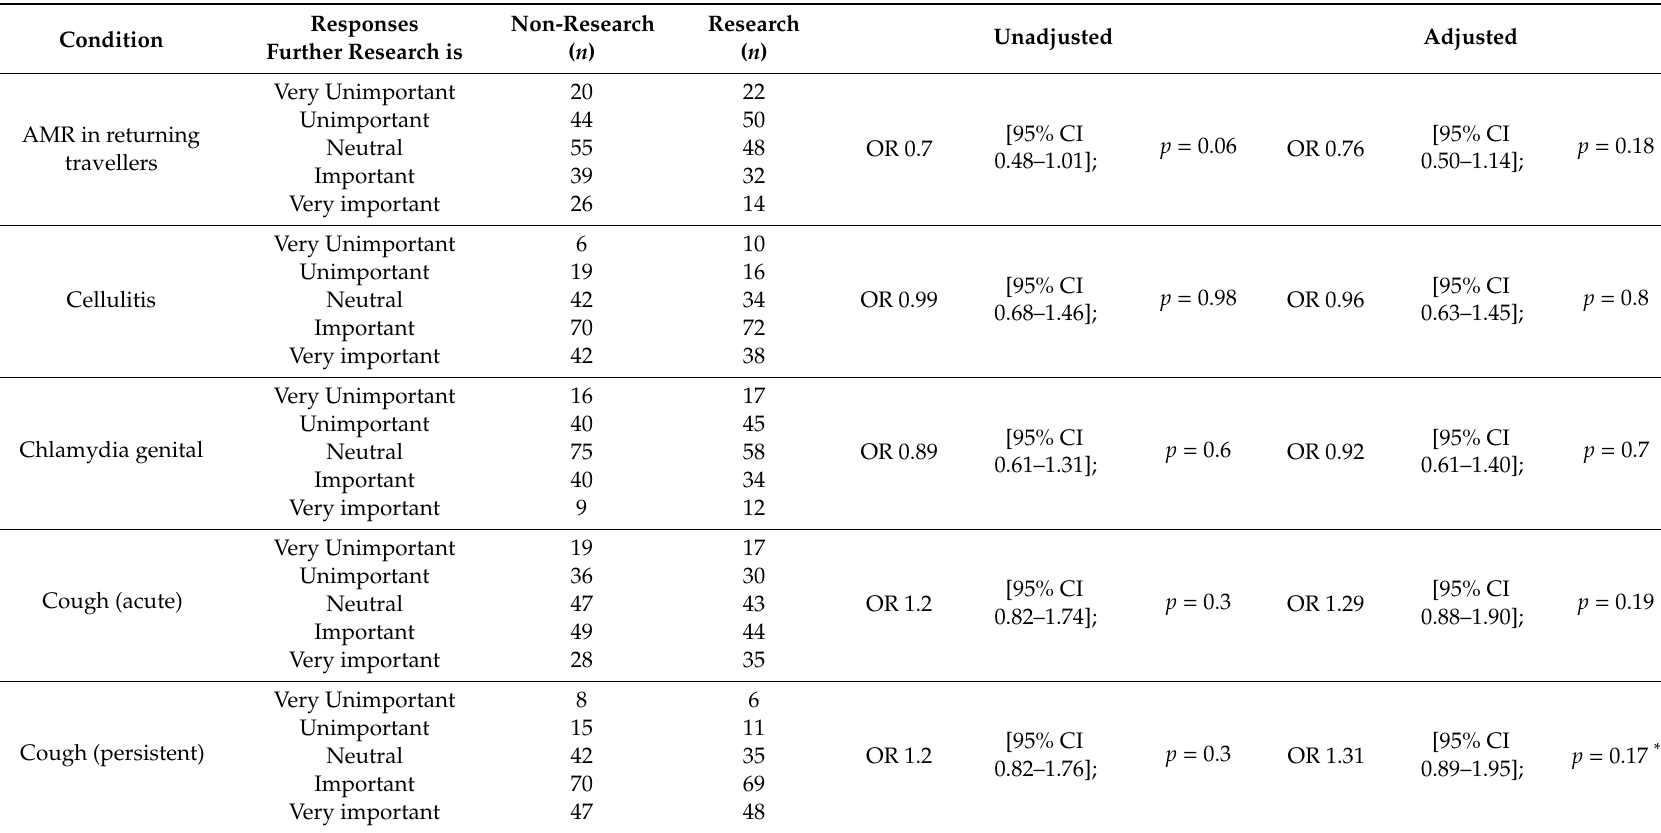
Table A1. Comparison between researchers and non-researchers in Question 1 responses. The p -value obtained from the likelihood ratio test (LRT), except where indicated